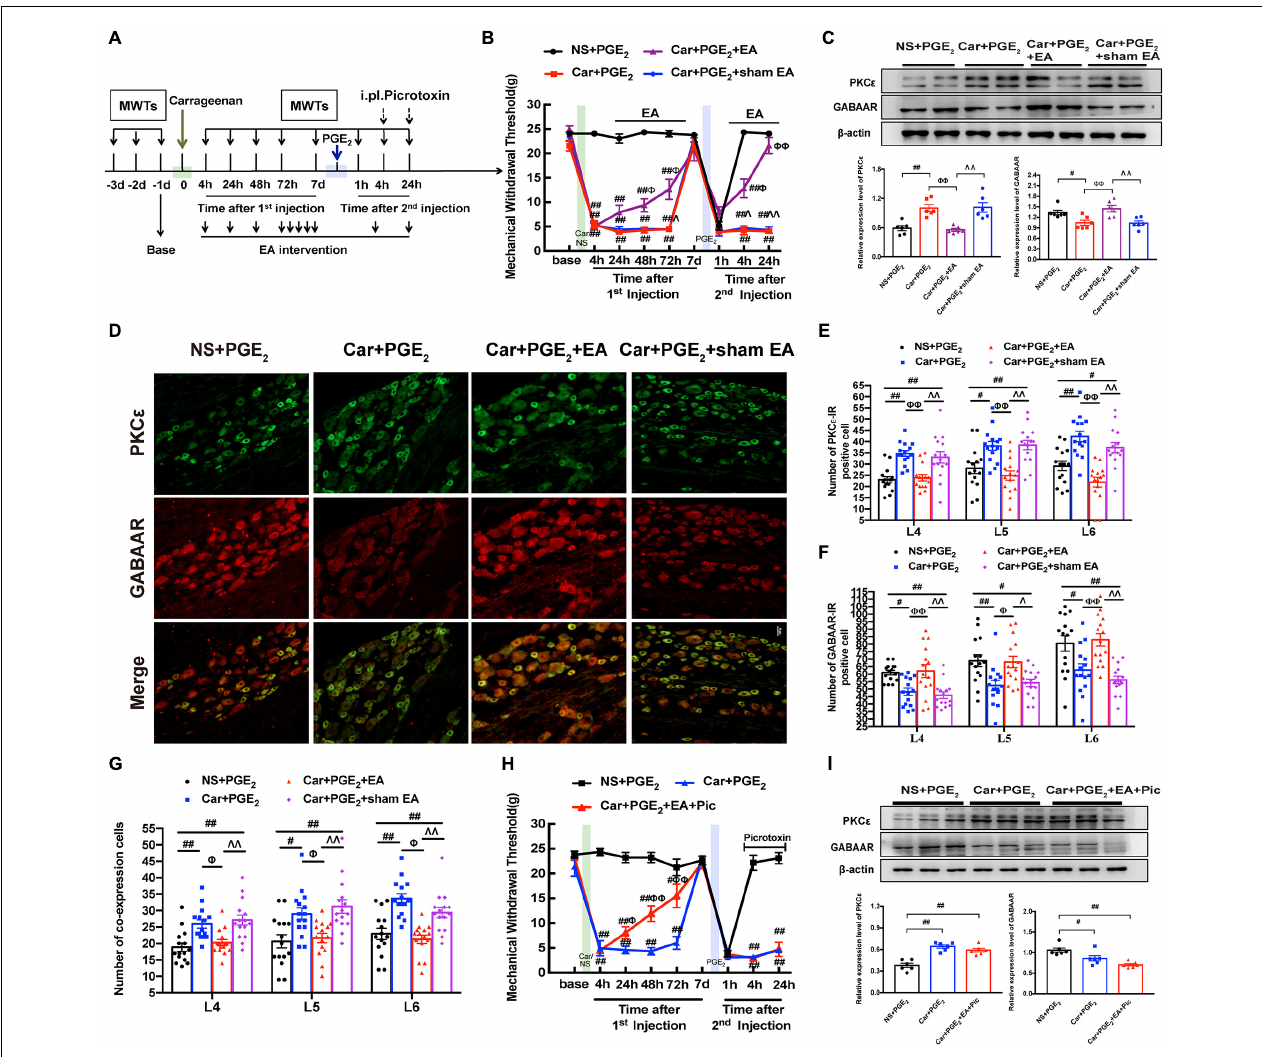
FIGURE 5 | EA regulates the transition from acute to chronic pain and GABAAR expression in the L4-L6 DRG. (A) The protocol of EA administration experiment. (B) MWT of hyperalgesic priming rats received EA or sham EA stimulation. n = 6. (C) The quantification of the Western blots results and a representative Western blot showing PKC ε and GABAAR protein isolated from the DRG 24 h after 2nd injection. (D) Representative images of PKC ε -IR positive neurons (green) merged with GABAAR-IR positive neurons (red) in lumbar DRGs of hyperalgesic priming rats. (E) The quantification of PKC ε -IR positive neurons in L4, L5 and L6 DRG, respectively. (F) The quantification of GABAAR-IR positive neurons in L4, L5 and L6 DRG, respectively. (G) The quantification of PKC ε -IR positive neurons labeled with GABAAR in L4, L5 and L6 DRG, respectively. 15 section from three different rats. (H) Picrotoxin (1 µ M/25 µ L/paw) injection blocked the analgesic effect of EA on hyperalgesic priming rats. n = 6. (I) The quantification of the Western blots results and a representative Western blot showing PKC ε and GABAAR protein isolated from the DRG 24 h after 2nd injection. Data are presented as mean ± SEM, n = 6; ## P < 0.01 vs. NS + PGE 2 group; (cid:56)(cid:56) P < 0.01 vs. Car + PGE 2